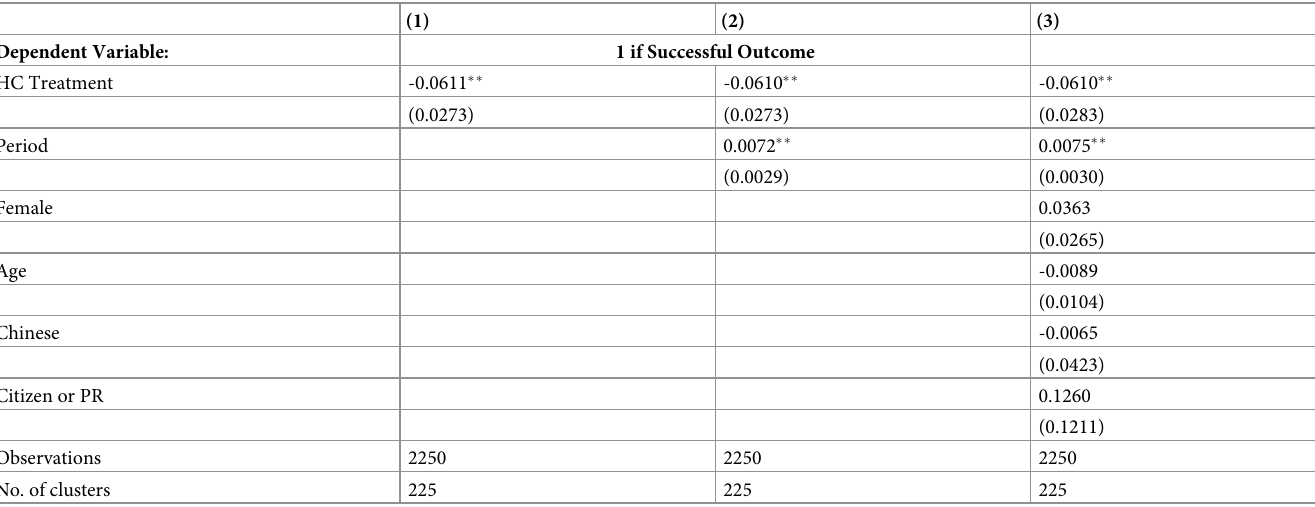
Table 2. Effect of heighted lying cost on